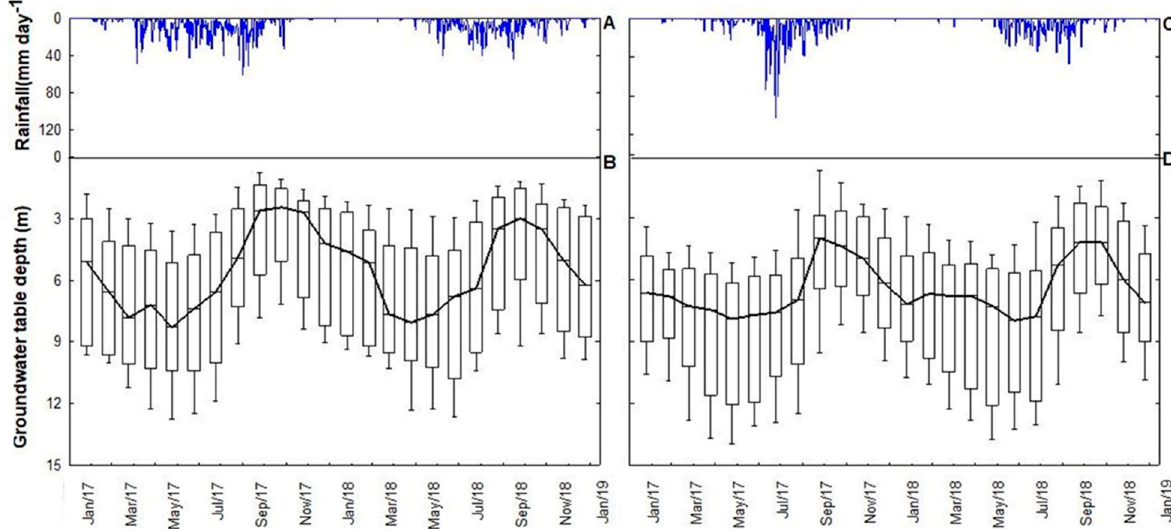
Figure 3. Boxplots of water table depth of 2017 and 2018. ( A , B ) is for Dangishta, and ( C , D ) is for Robit Bata watershed. Each box plot is based on data from 32 wells in Dangishta and 35 in Robit Bata, with 25th and 75th percentiles lower and upper ends. The black line passes through the median.